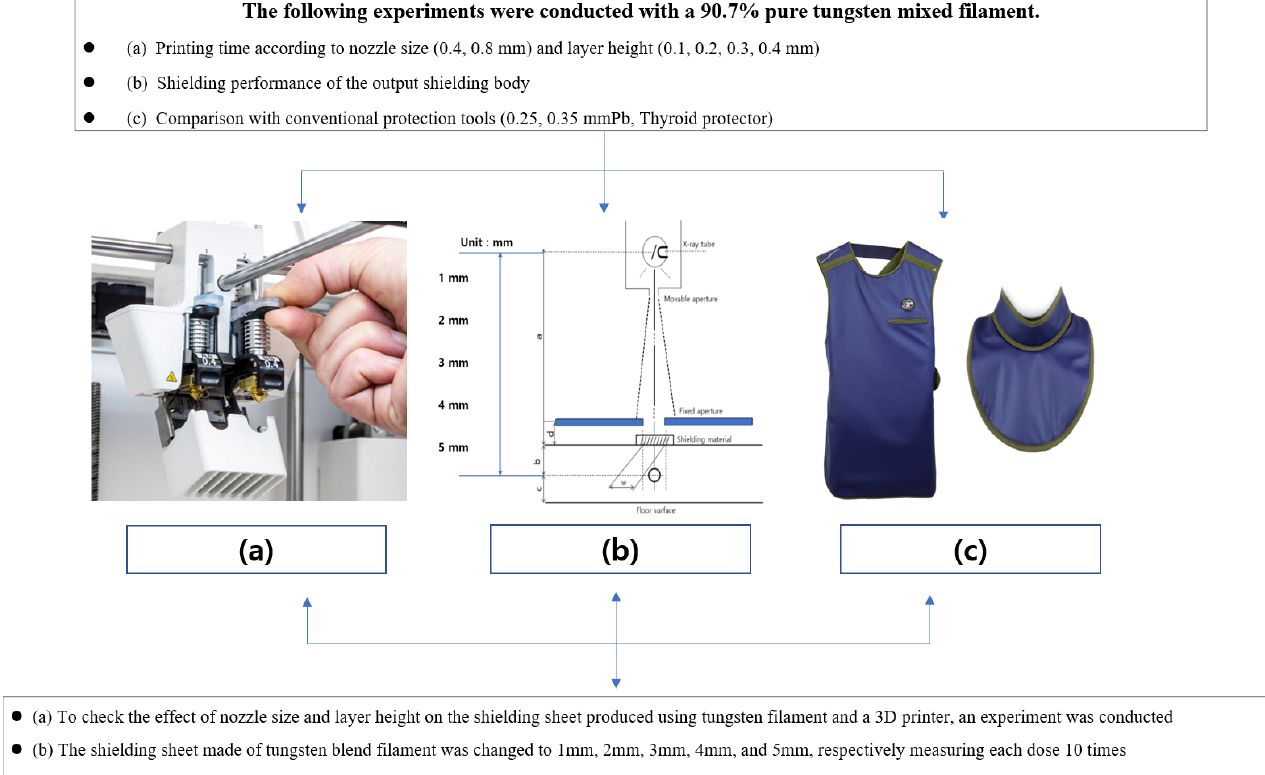
Figure 1. Flowchart of this study. ( a ) In the process of manufacturing and printing a shielding sheet using a 3D printer and a tungsten mixed filament, the change in the shielding ratio according to the nozzle size, layer, and height is evaluated. ( b ) In the case of shielding rate, it was tested through the lead equivalent test method of the Korean industry-standard X-ray protective products. ( c ) A comparative analysis was conducted using Apron and thyroid protectors used in clinical practice to confirm the possibility that the printed shielding sheet can replace the existing protective